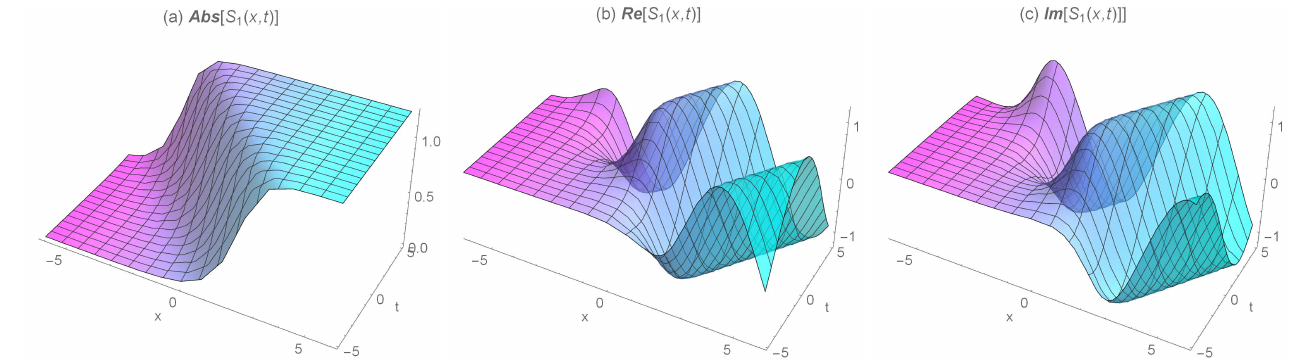
Figure 1. The 3D wave profiles for the absolute, real, and imaginary values of the dark (kink) soliton solution for b = 0.9, c = − 0.3, s = 1.5, k = 1, ϑ 0 = 0.2, ε 1 = ε 2 = 1, ε 3 = 1.2, Ω = 0.5.